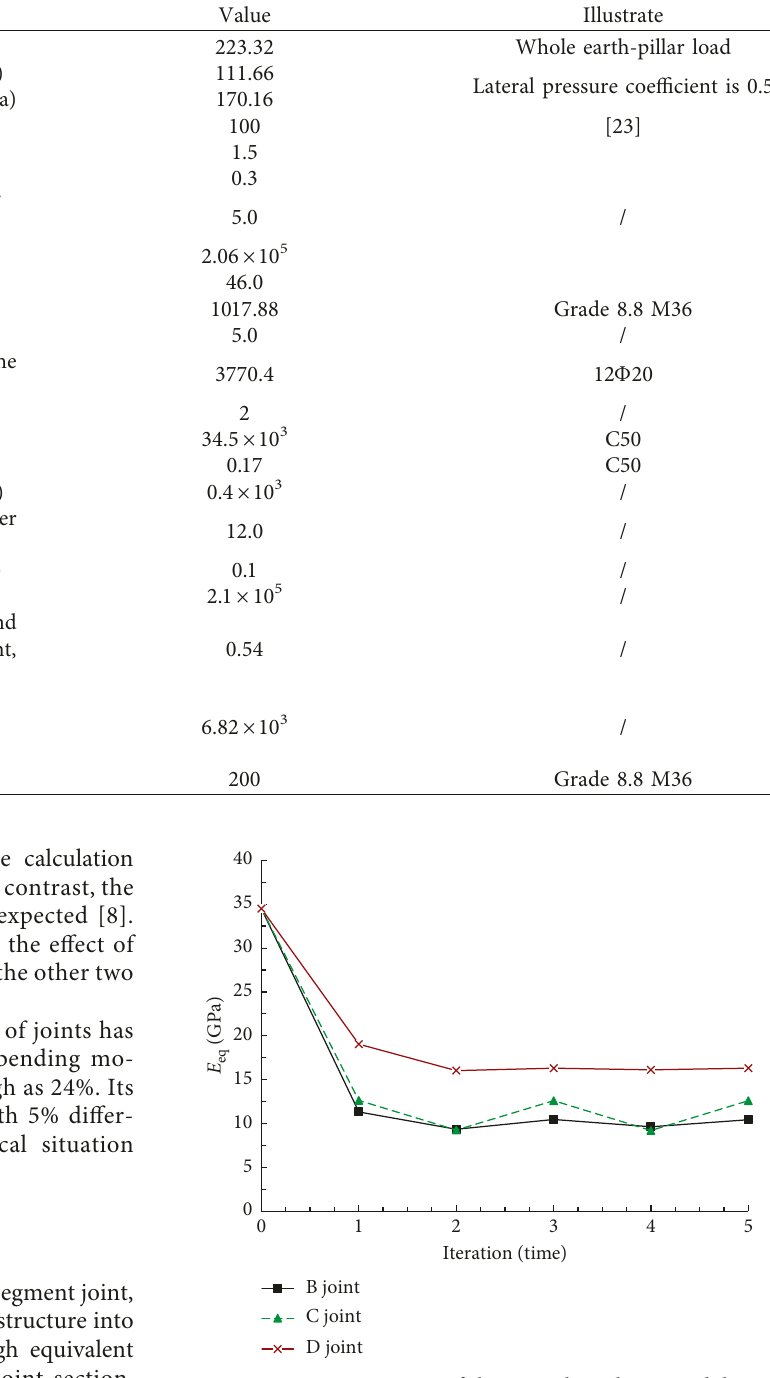
Figure 11: Iteration process of the equivalent elastic modulus on joint